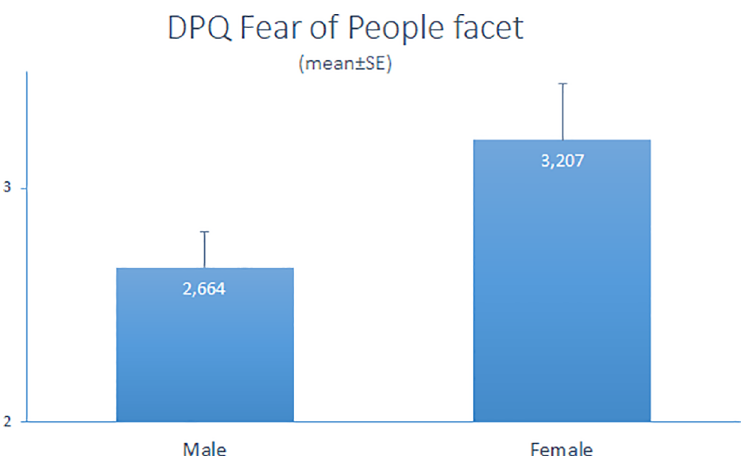
Fig 3. Female Bali dogs had higher scores in the DPQ Fear of People facet than males (p < 0.05).